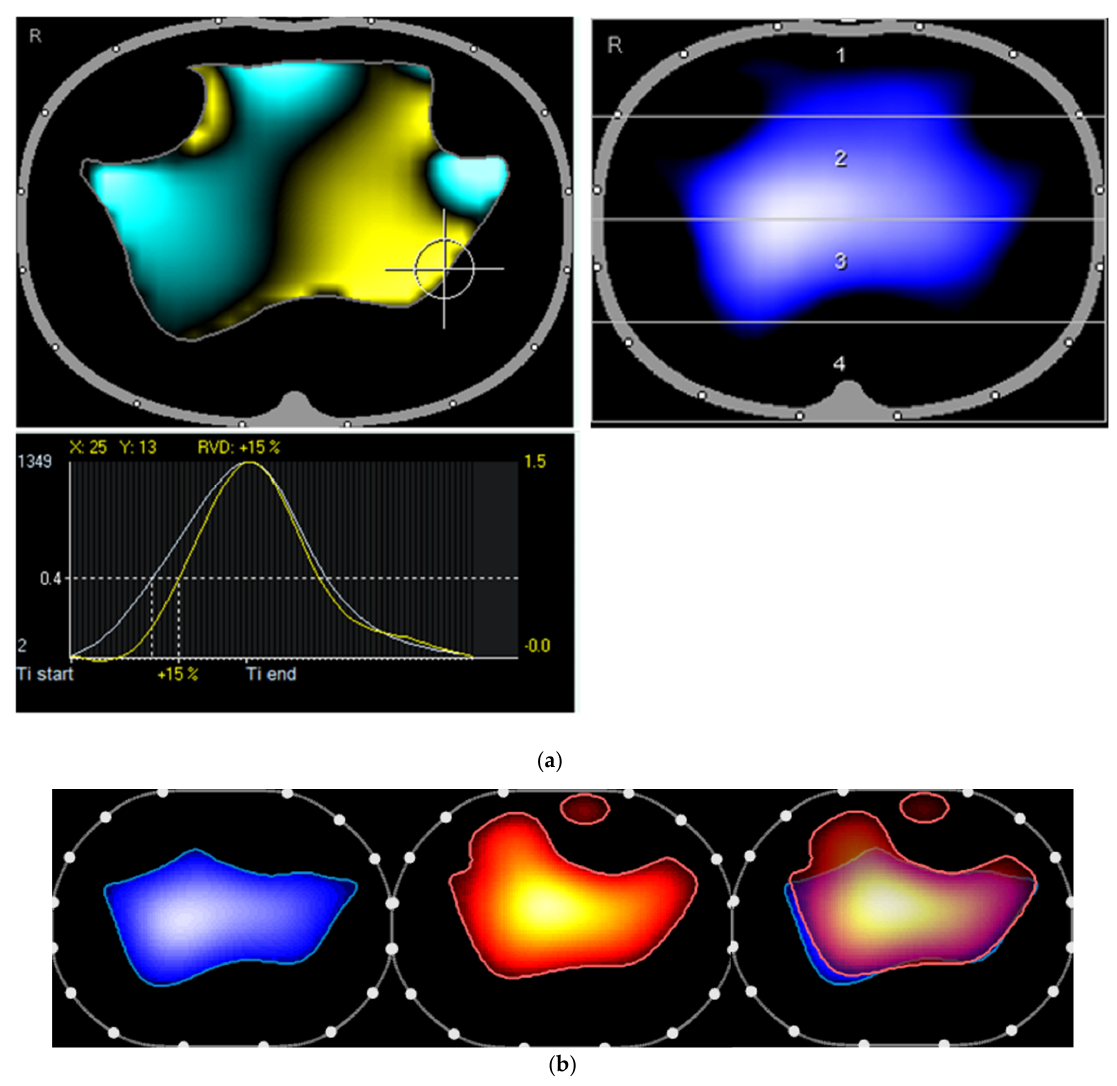
Figure 2. ( a. ) First presentation of the patient: Tidal image shows reduced ventilation on both ventral sides and dorsal left. The enhanced color map shows a visually recognizable irregular shape of the ventilation contour similar to thorn apple forms. Recognizable is a pronounced regional ventilation delay (left dorsal; +15 %). ( b. ) First presentation of the patient: Largely consistent distribution of ventilation and pulsatile blood flow, except for a small right ventral right region, where pulsation but no ventilation is observed.